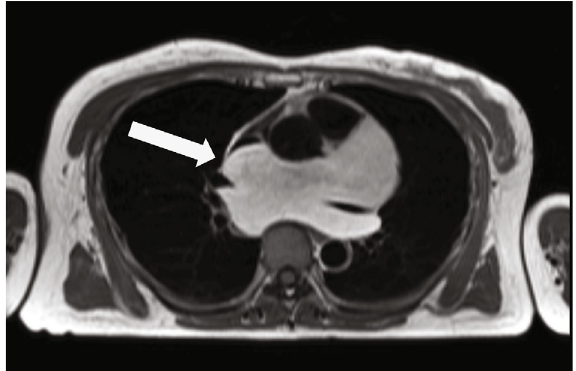
Figure 2: Preoperative magnetic resonance imaging fi ndings. Arrows indicate mass.